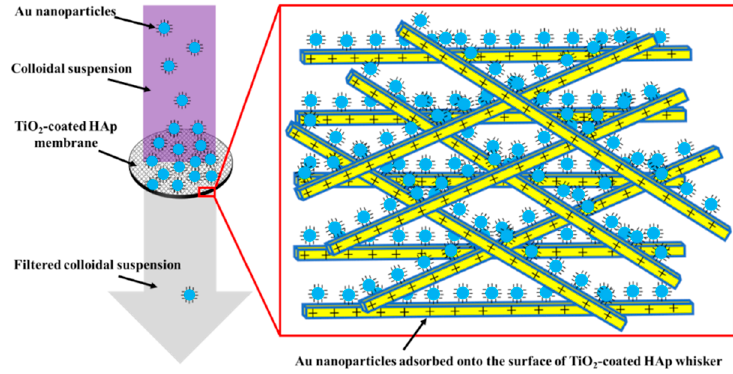
Figure 7. Schematic illustration of the Au colloidal suspension filtered by the TiO 2 -coated HAp membrane, with a locally enlarged schema to illustrate the adsorption of Au nanoparticles onto the surface of the TiO 2 -coated HAp whisker as a result of the electrostatic attractive interaction of their negative and positive surface charges.